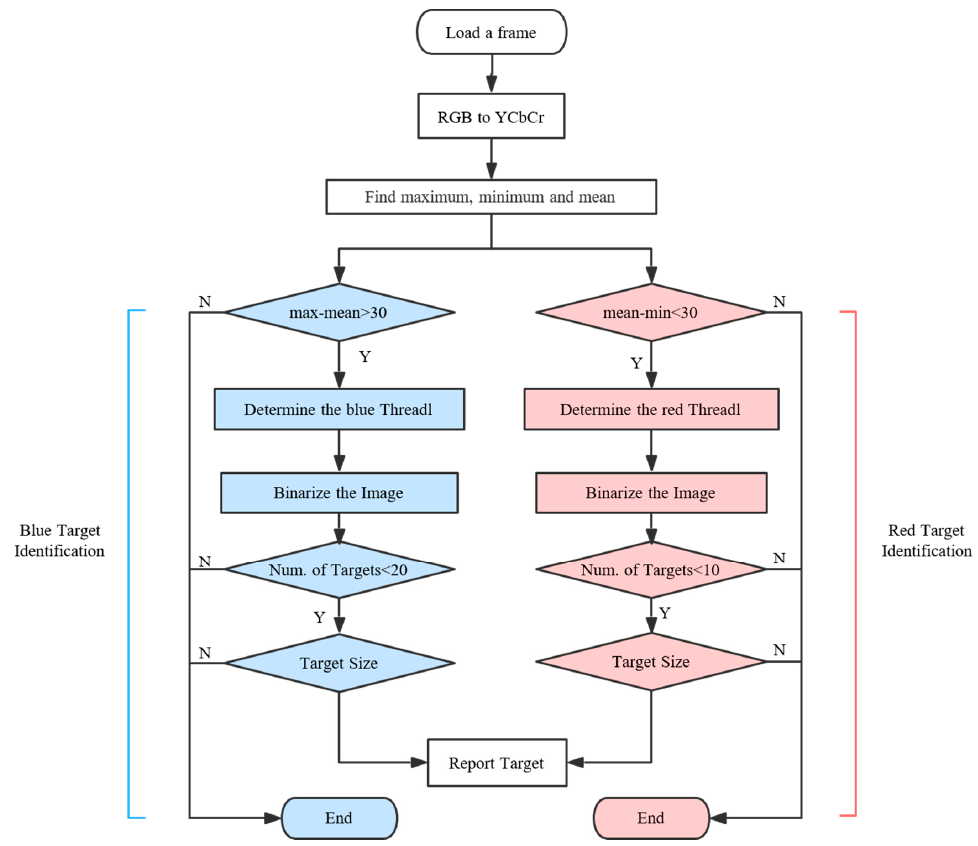
Figure 6. Flowchart of the identification algorithm.